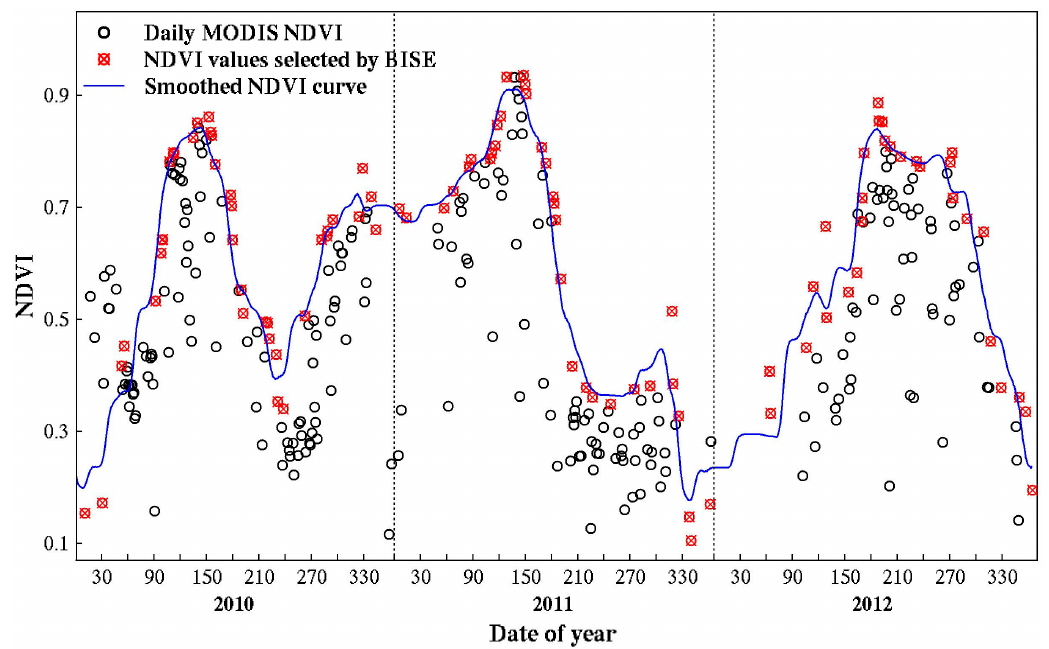
Figure 3. Example of a MODIS Normalized Difference Vegetation Index (NDVI) time-series for winter wheat. MODIS NDVI values of less than 0.1 were removed after applying snow and cloud mask. Only selected NDVI values by Best Index Slope Extraction (BISE; red dots with crosses) were used to construct 3-year NDVI profile for phenometrics extraction. The blue curve is an example of using the Savitzky–Golay filter (SG) algorithm for smooth interpolation.